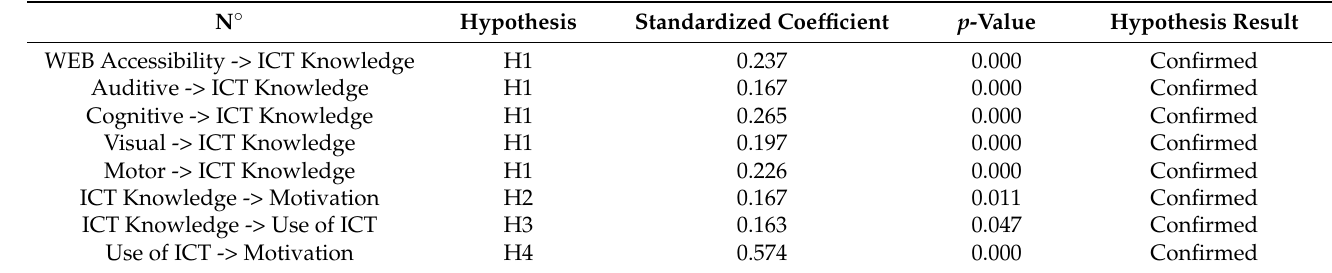
Table 4. Estimated model results.